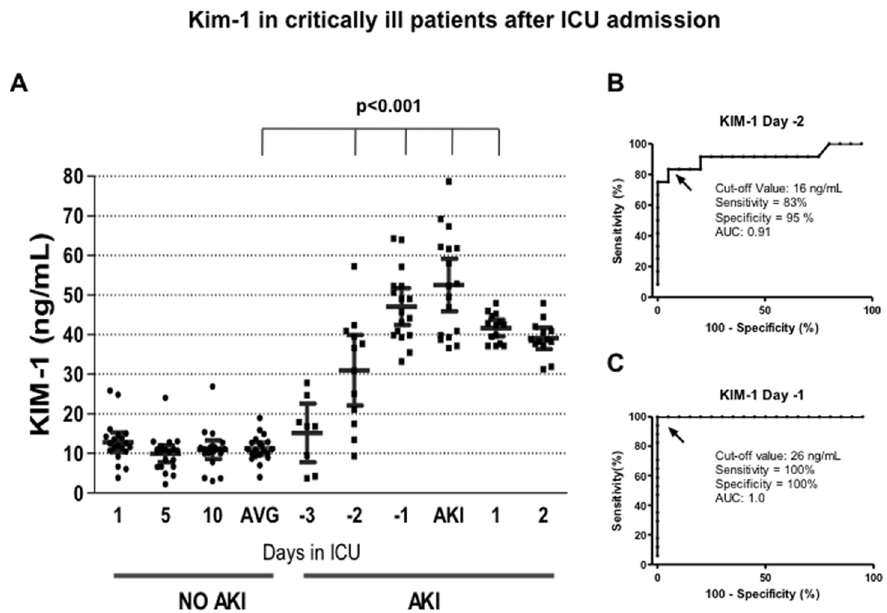
Figure 1. Kim-1 in critically ill patients after ICU admission. A) Urinary Kim-1 levels assessed by ELISA from AKI and no-AKI patients. In no-AKI patients, Kim-1 was measured at days 1, 5 and 10 of their stay in the ICU; whereas, in AKI patients Kim-1 was measured from ICU admission until two days after the diagnosis of AKI. Every point represents the biomarker value in each urine sample, and the lines depicted the mean and 95% confident interval. AVG=average of urinary Kim-1 levels in no-AKI patients determinated at 1, 5, and 10 days after ICU admission. B) Specificity and sensitivity of Kim-1 to detect AKI two days before the AKIN criteria, determined by ROC analysis. C) Specificity and sensitivity of Kim-1 to detect AKI one day before the AKIN criteria, determined by ROC analysis.